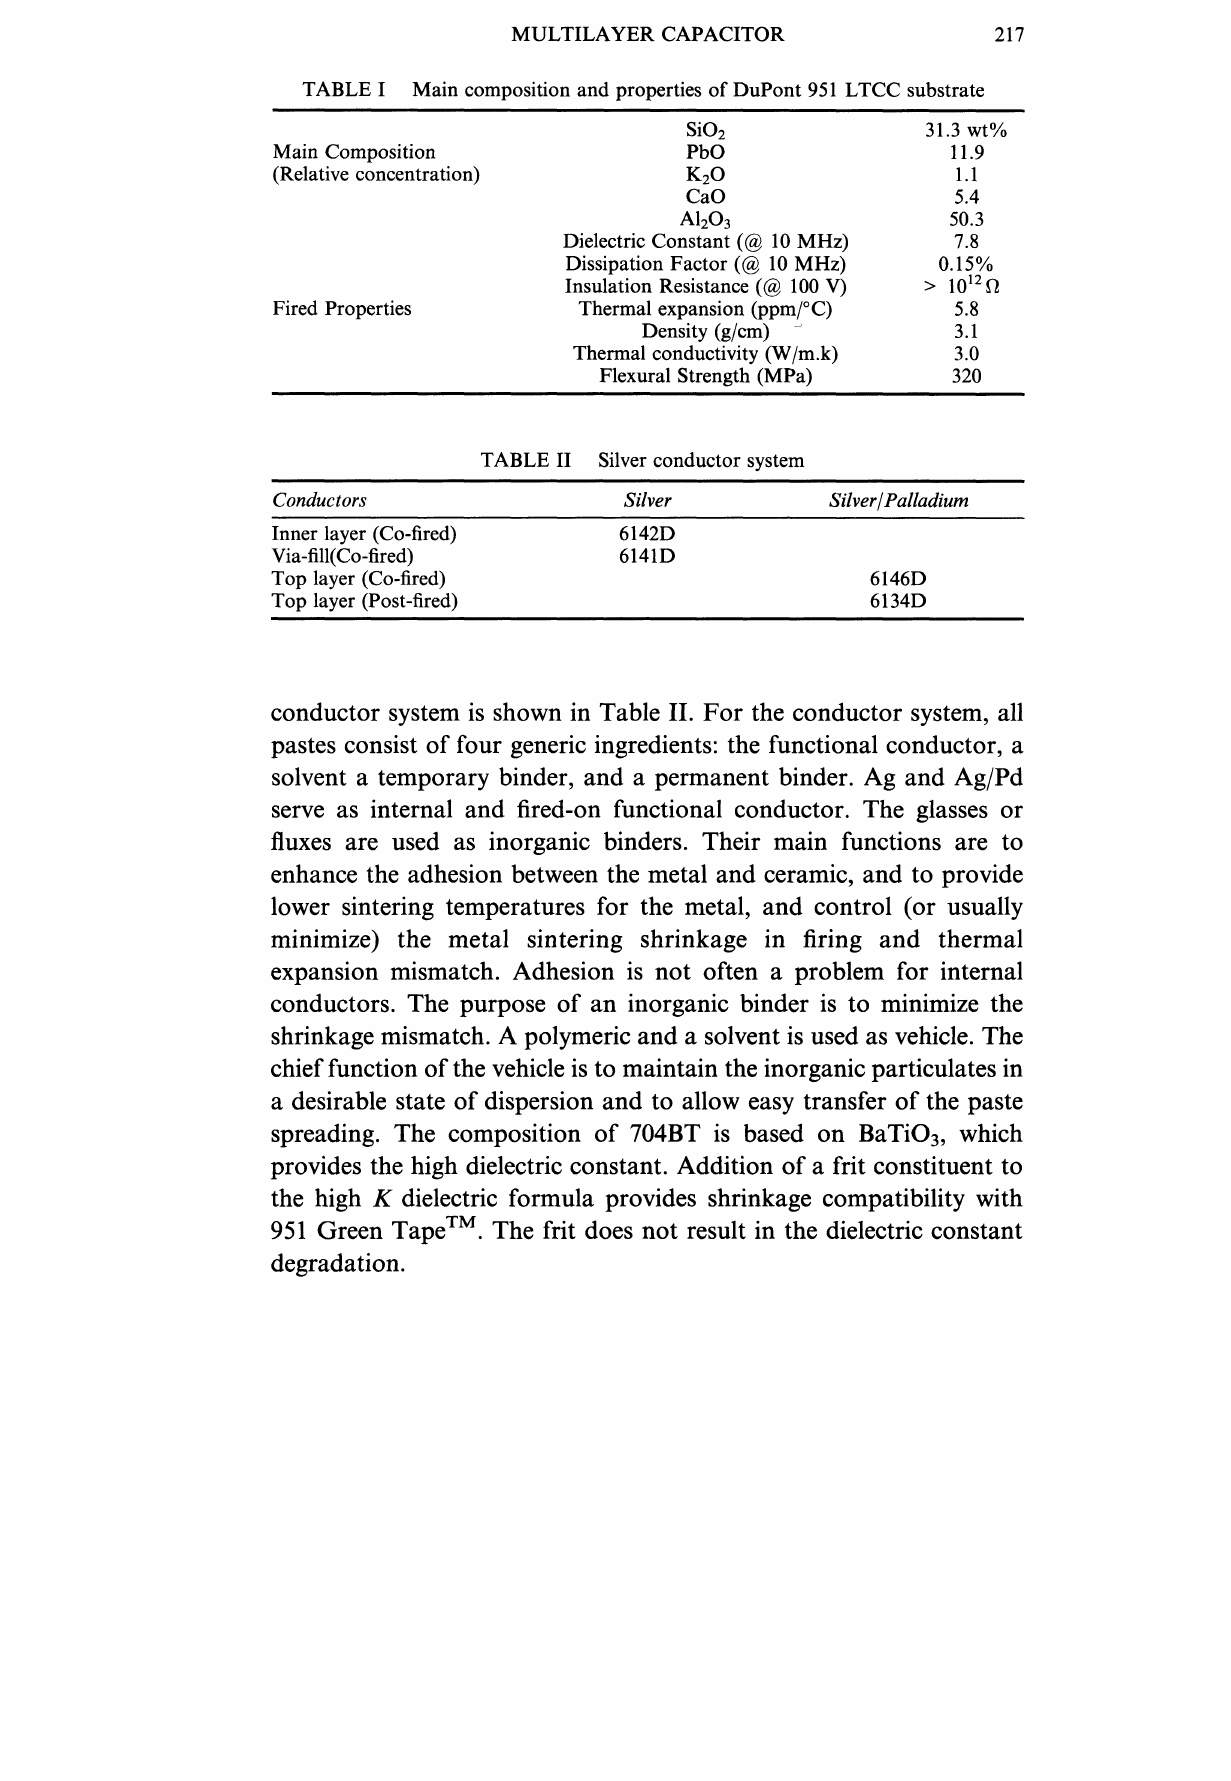
Fired Properties